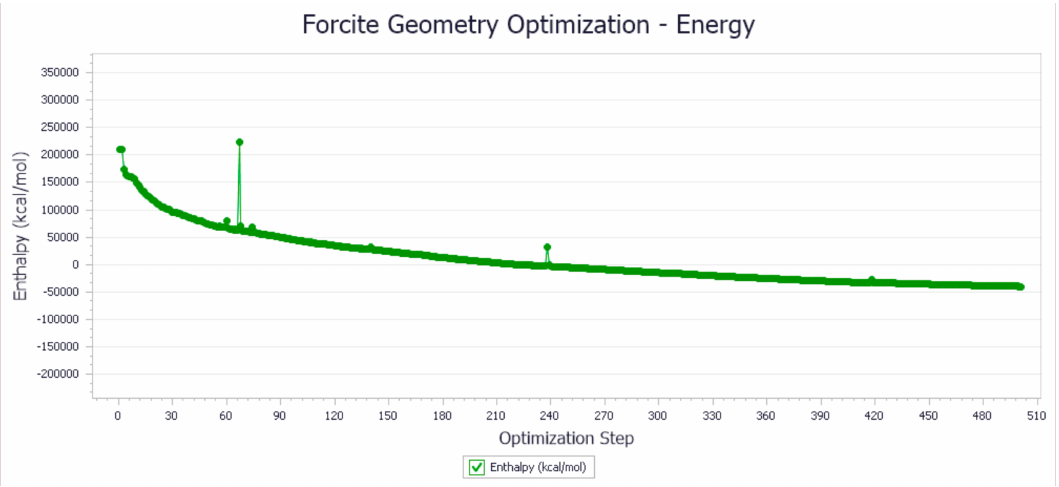
Figure 14. Demulsifier 10 # oil–water interface geometry optimization energy trend.